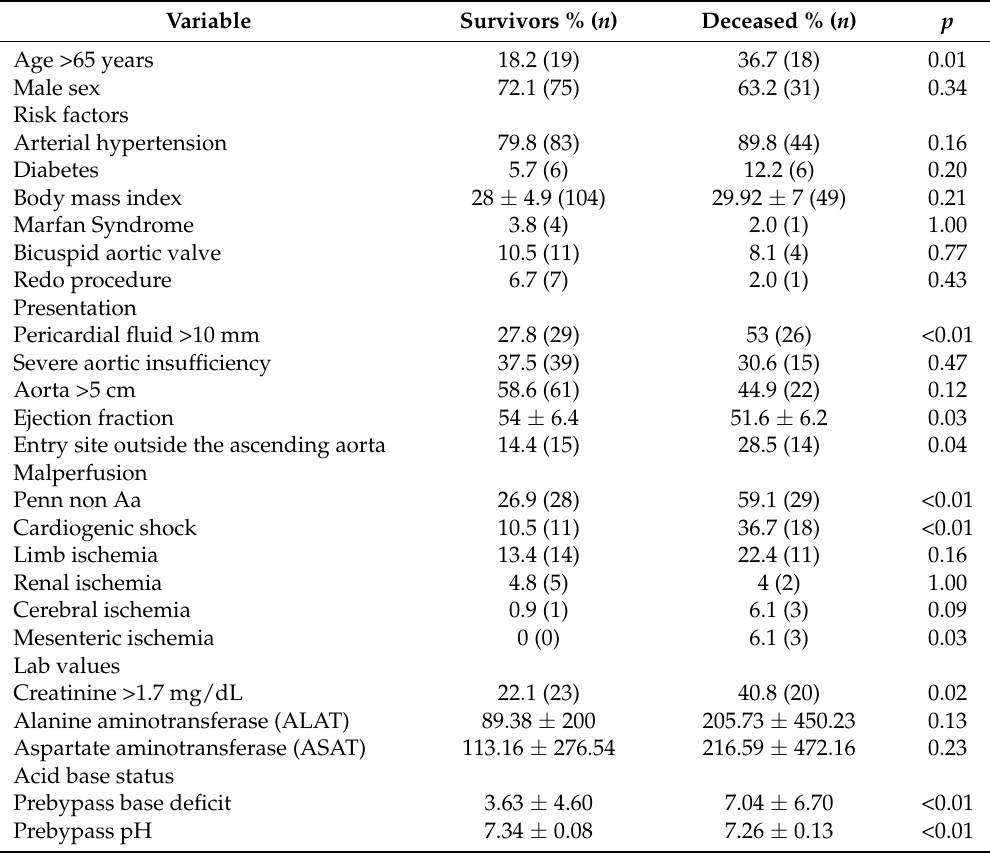
Table 1. Univariate preoperative risk assessment.